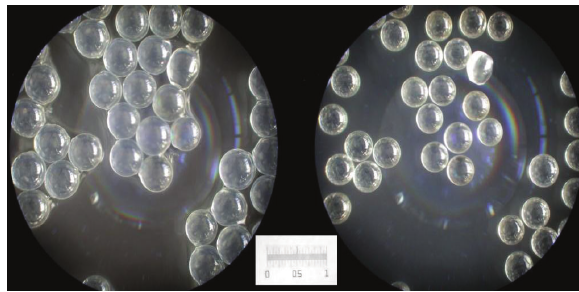
Fig. 6 – Ion exchanger particles during and after Fig. 6 - Photos of ion exchanger particles during and after drying Pavel Hoffman: Effect of fluidized bed stirring on drying process of adhesive particles